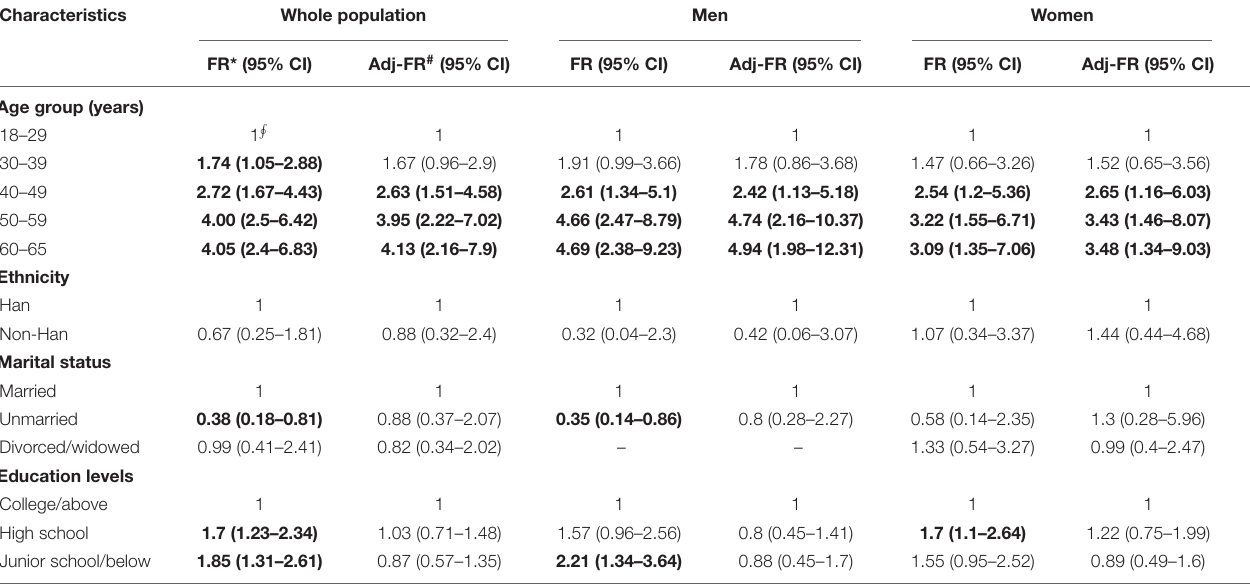
TABLE 3 | Factors associated with the detection of anti- C. trachomatis Pgp3 IgG in a community population of Northern China in 2014. Characteristics Whole